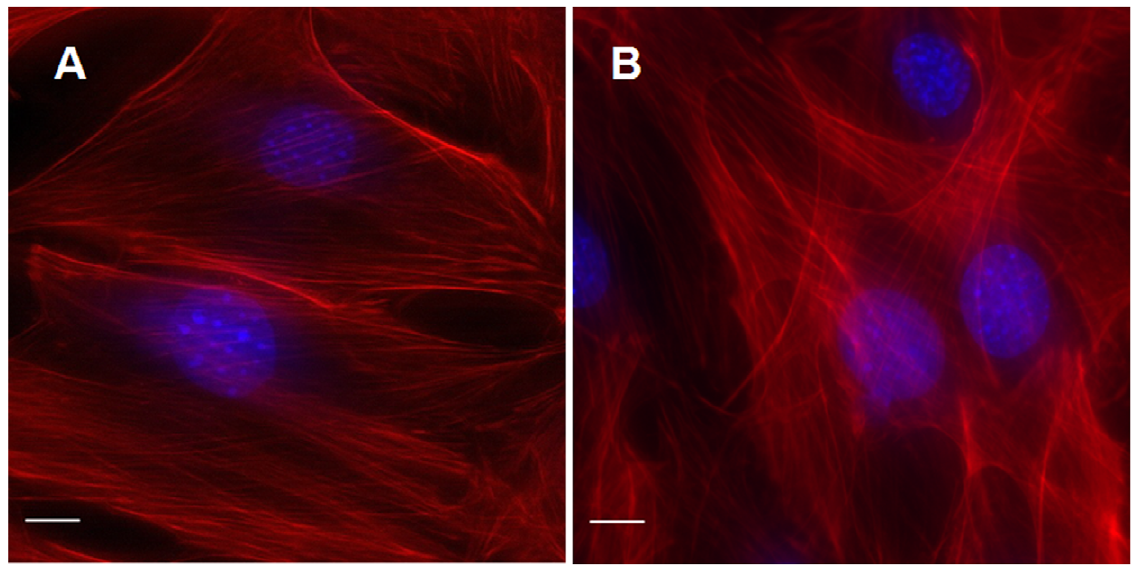
Figure 6. Pulsed ultrasound radiation affects the arrangement of actin cytoskeleton in MC3T3-E1 osteoblasts. Pulsed ultrasound was applied for 1 min, cells were then rinsed three times with fresh DPBS (total time,10 min), then fixed and stained with rhodamine-phalloidin. Actin stress fibers were imaged in control cells (A) and 10 min (B) after ultrasound radiation. Actin stress fibers increased following pulsed ultrasound radiation. Scale bar, 10 m m.